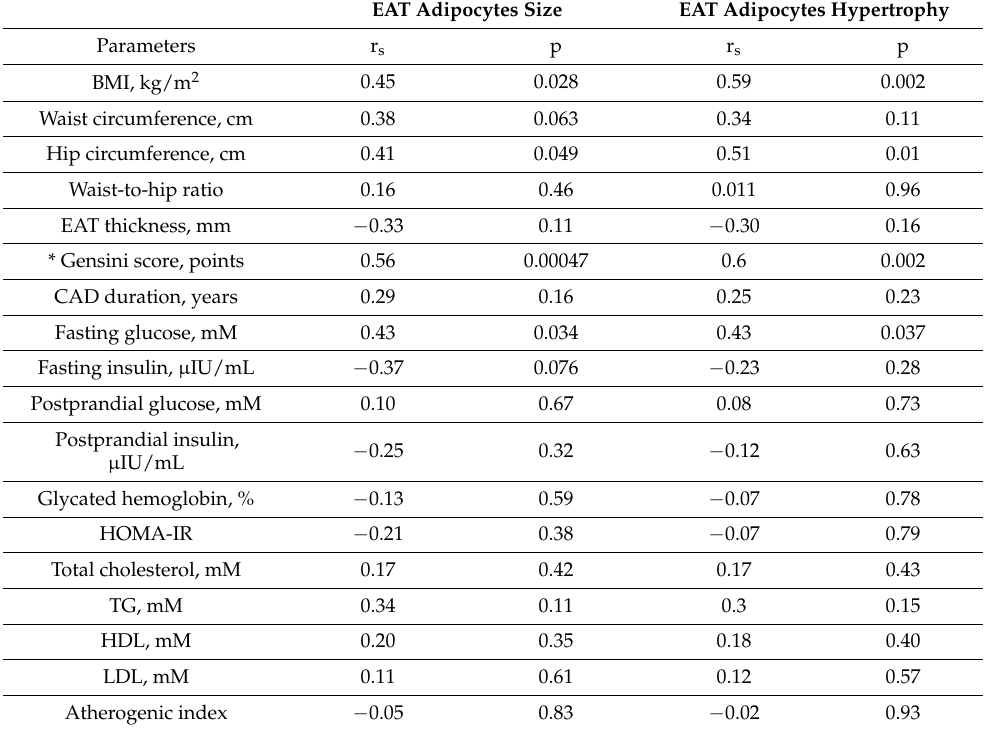
*—data were adjusted to gender; r s , Spearman rank correlation coefficient; CAD, coronary artery disease; EAT, epicardial adipose tissue; BMI, body mass index; HOMA-IR, homeostatic model assessment of insulin